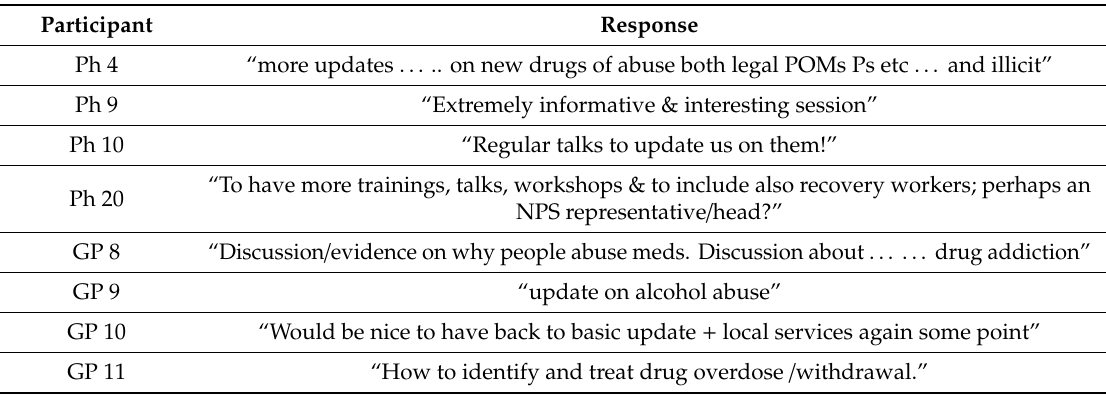
Table 6. Free text responses regarding future sessions and additional comments in the evaluation of GP Shared Care Event and CPD Pharmacy